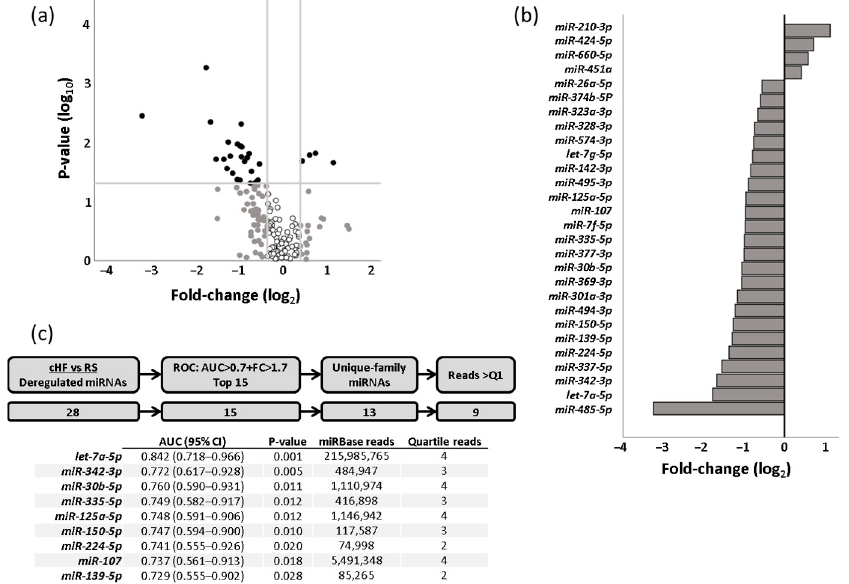
Figure 1. miRNA profiling in cHF patients and reference subjects. ( a ) miRNA profiling as a dot plot in a Cartesian graph. x -axis represents log 2 (fold-change) and y -axis represents log 10 (median concentration p -value). miRNAs with 1.3-fold changes in concentration level (greater than 0.38 [log 2 (1.3)] and less than 0.38 [log 2 (1/1.3)]) and significant p -value are shown in solid black dots. miRNAs with 1.3-fold changes in concentration level (greater than 0.38 [log 2 (1.3)] and less than 0.38 [log 2 (1/1.3)]) but non-significant p -value are shown in solid grey dots. miRNAs with less than 1.3-fold changes in concentration level (lower than 0.38 [log 2 (1.3)] and higher than 0.38 [log 2 (1/1.3)]) and non-significant p -value are shown in black circles. ( b ) Bar graph indicating changes in the expression of miRNAs between patients and reference subjects. ( c ) Schematic workflow for miRNA selection. AUC: area under the curve; cHF: chronic heart failure; FC: fold-change; Q1: first (lowest) quartile; RS: reference subjects; ROC: receiver operating characteristic curve.